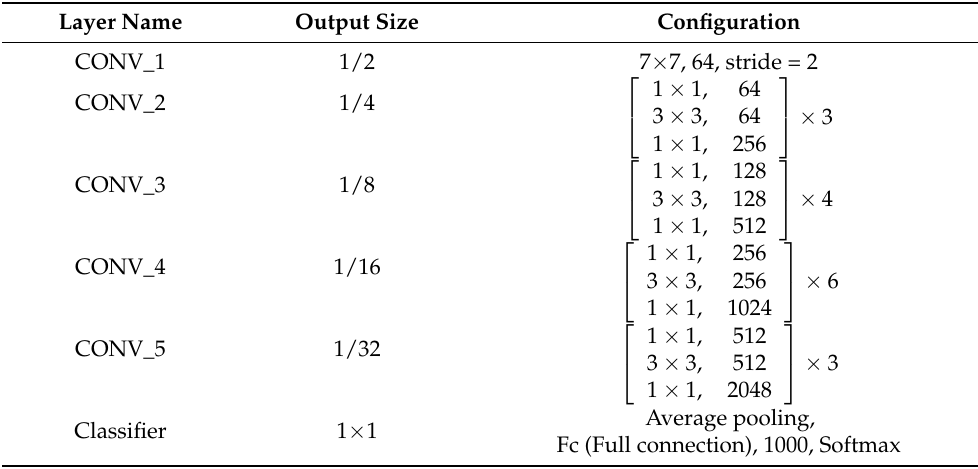
Table 1. Convolution kernel sizes and output sizes of the ResNet50